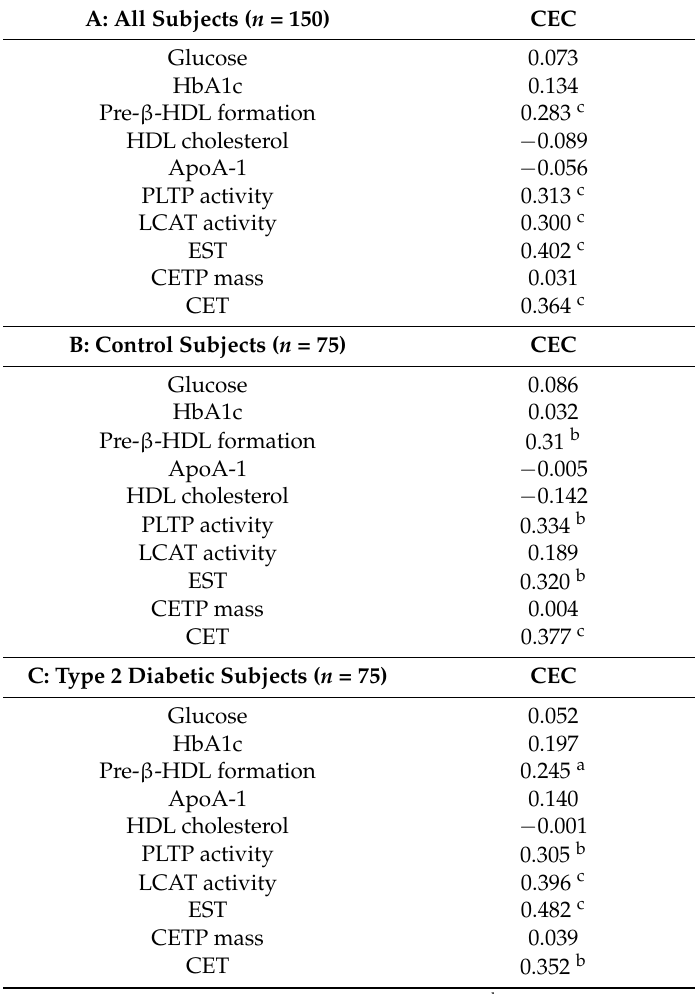
Table 3. Univariate correlations of cholesterol efflux capacity (CEC) with plasma glucose, HbA1c, pre- β -HDL formation, high-density lipoprotein (HDL) cholesterol, apolipoprotein (apo)A-1, phospholipid transfer protein (PLTP) activity, lecithin–cholesterol acylesterase (LCAT) activity, cholesterol esterification (EST), cholesteryl ester transfer protein (CETP) mass and cholesteryl